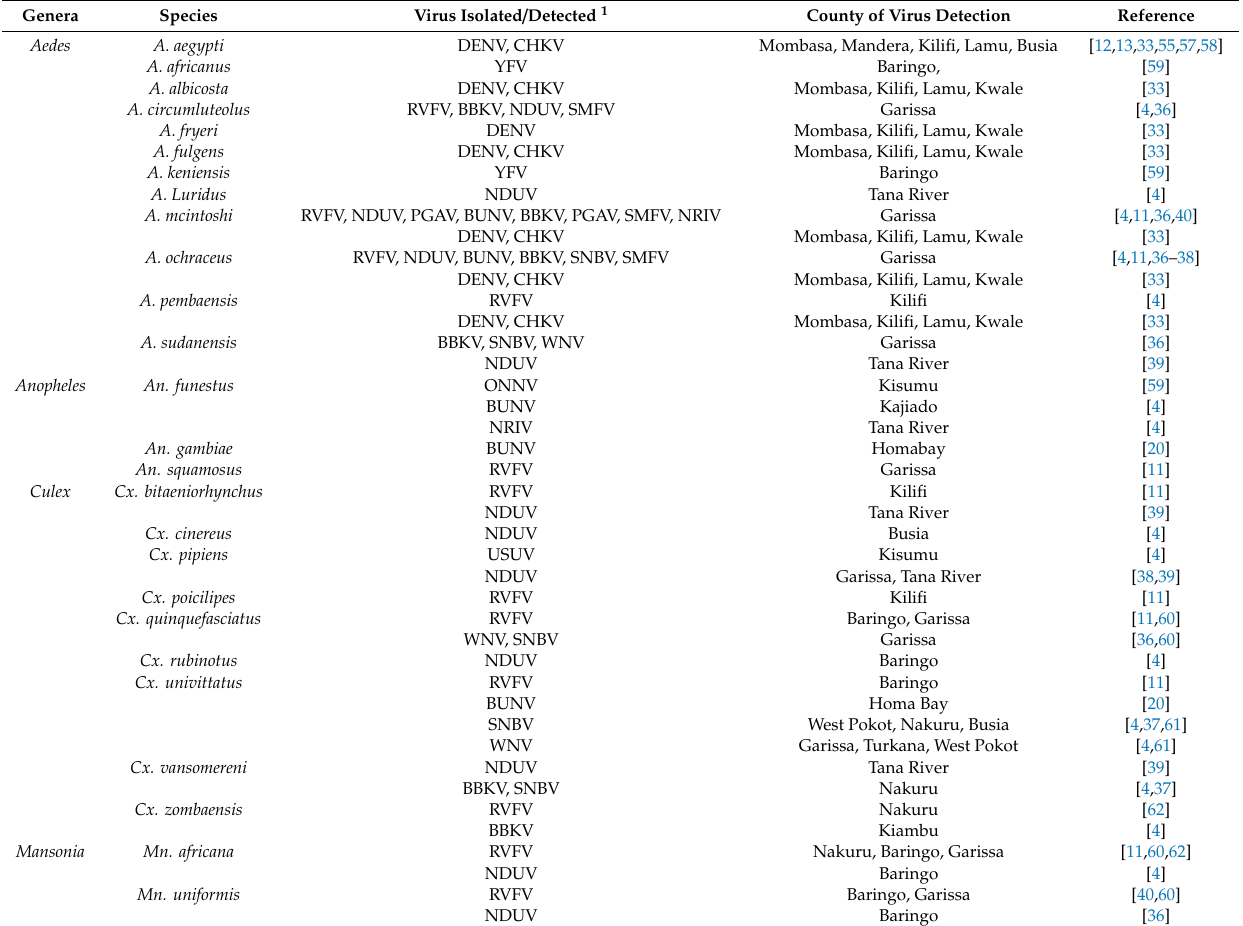
Table 1. Summary of the main mosquito species in which viruses have been detected / isolated in